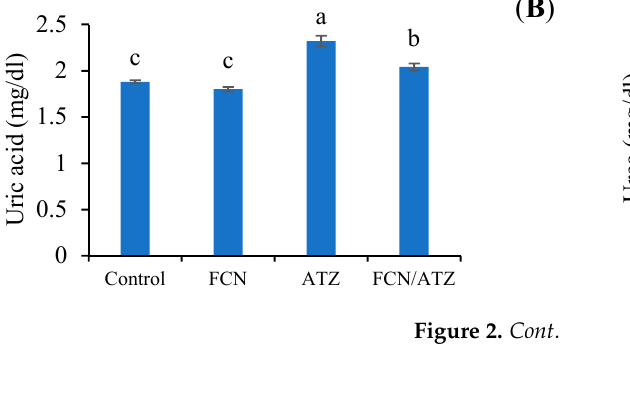
Means ± S.E. in the same row with different letters; differ significantly ( p < 0.05). The groups are the control, fish fed dietary fucoidan (FCN), fish fed basal diet and exposed to atrazine (ATZ), and fish fed FCN and exposed to ATZ (FCN/ATZ).